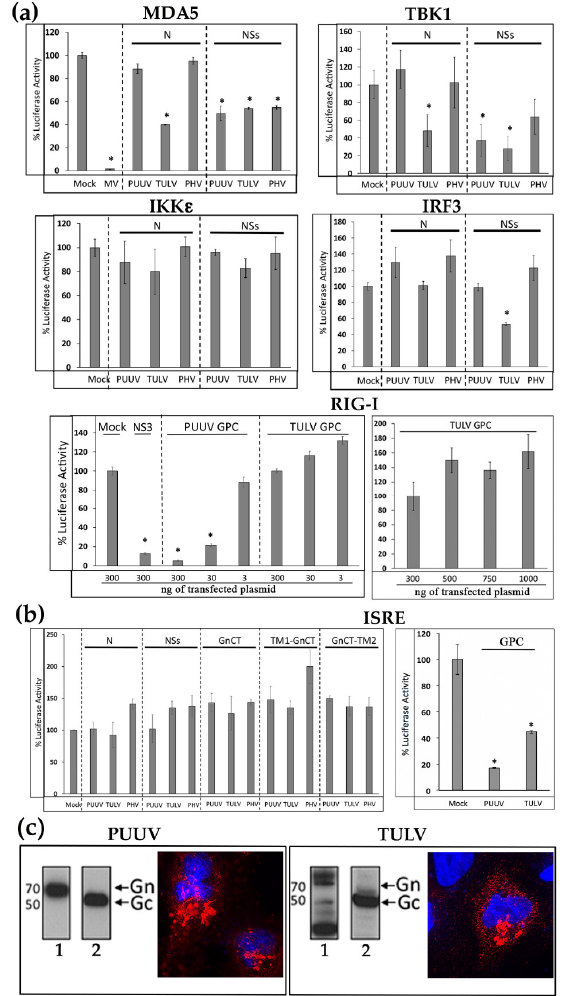
Figure 2. Effect of hantaviral proteins on different elements of the IFN signaling cascade. HEK293T cells were used 24h post-transfection with 300 ng of plasmid encoding 3xFlag-tagged proteins of PUUV, TULV, or PHV, as indicated in the different panels. In ( a ) is shown the inhibitory activity of the different N and NSs proteins on IFNβ Luc activity induced by different elements of the signaling cascade, i.e., MDA5, TBK1, IKKε, or IRF3-5D and of different amount of full-length GPC on RIG-I induced IFNβ-Luc activity. The V protein of measles virus (MV) and BTV-NS3 proteins served as positive control for inhibition of MDA5 and RIG-I-mediated IFN activation, respectively. In ( b ) is shown the effect of plasmid encoding N, NSs, and the different forms of GnCT (left panel) and of GPC (right panel) on ISRE-Luc activity triggered by adding 1000 IU of human IFNβ to transfected HEK293T cells. The histograms represent the percentage of firefly luciferase activity obtained from three independent experiments performed in triplicates, error bars correspond to standard deviation to the mean and asterisk to statistically significant differences with a p value < 0.005. ( c ) The correct maturation of Gn and Gc glycoproteins from PUUV and TULV GPC constructs transfected in VeroE6 cells was confirmed by western blot assay. Gn (lane 1) was detected using anti-StrepTag- HRP mAb and Gc (lane 2) while using the mAb 10B8 and then anti-mouse IgG coupled to HRP. Immunofluorescence staining of Gn in red was obtained using anti-StrepTag mAb and then anti- mouse IgG coupled to Alexa 555. The nuclei were stained in blue with